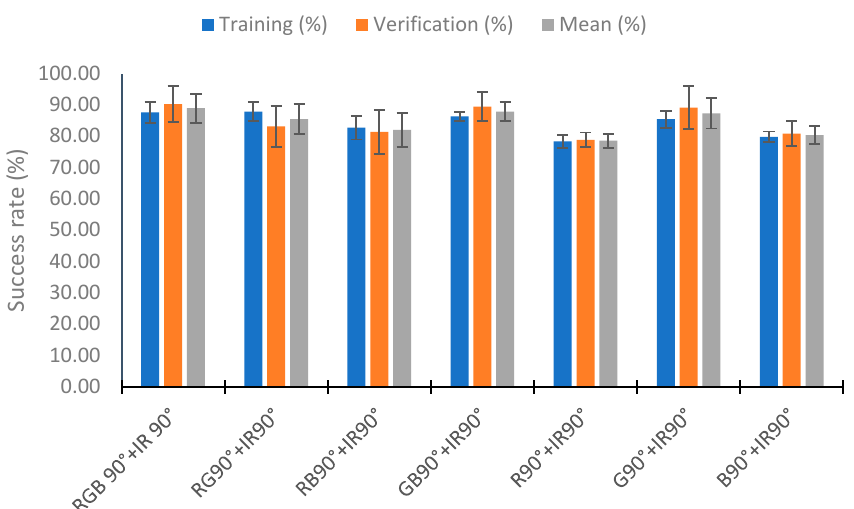
Figure 24. Success rate in the neural network with the data of the different RGB and IR light at 90°.